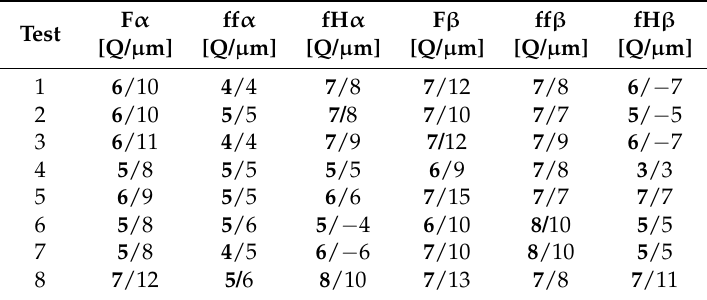
Table 15. Achieved gear qualities according to DIN3962 [19] for tests 1 to 8 of hard machining with special inserts of type 1010.